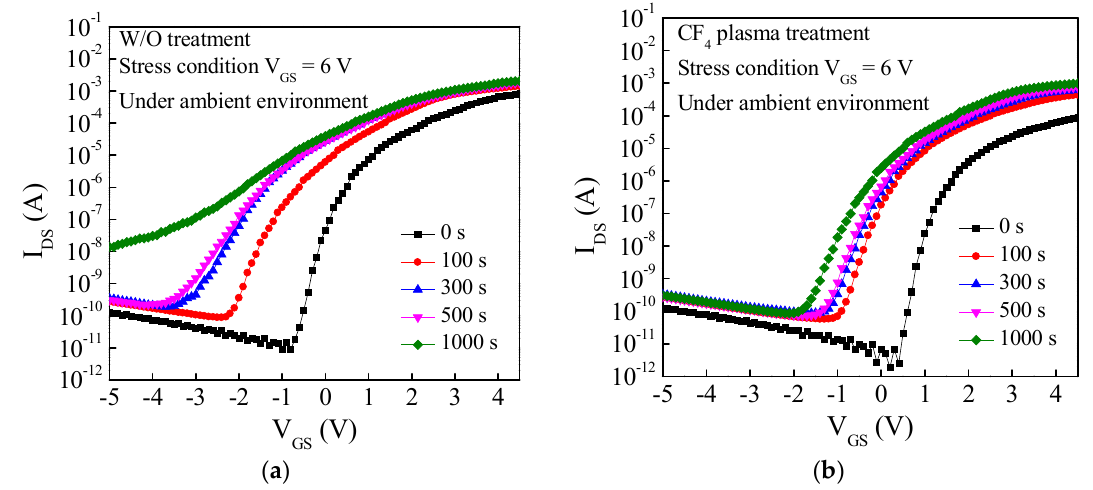
Figure 5. Transfer curves (I DS -V GS ) of a-IGZO TFT with and without the CF 4 plasma treatment under positive gate bias stress (PGBS) (V GS = 6 V).